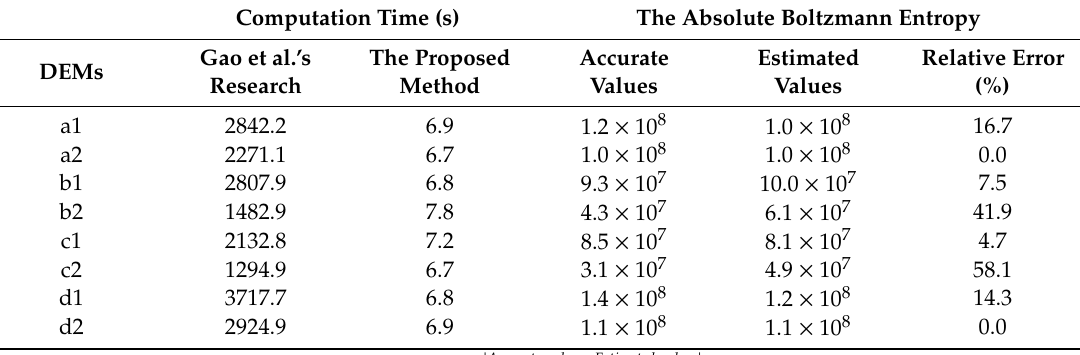
Table 2. The absolute Boltzmann entropy and its computation time, as calculated by the traditional method used by Gao et al. [18] and our proposed method.